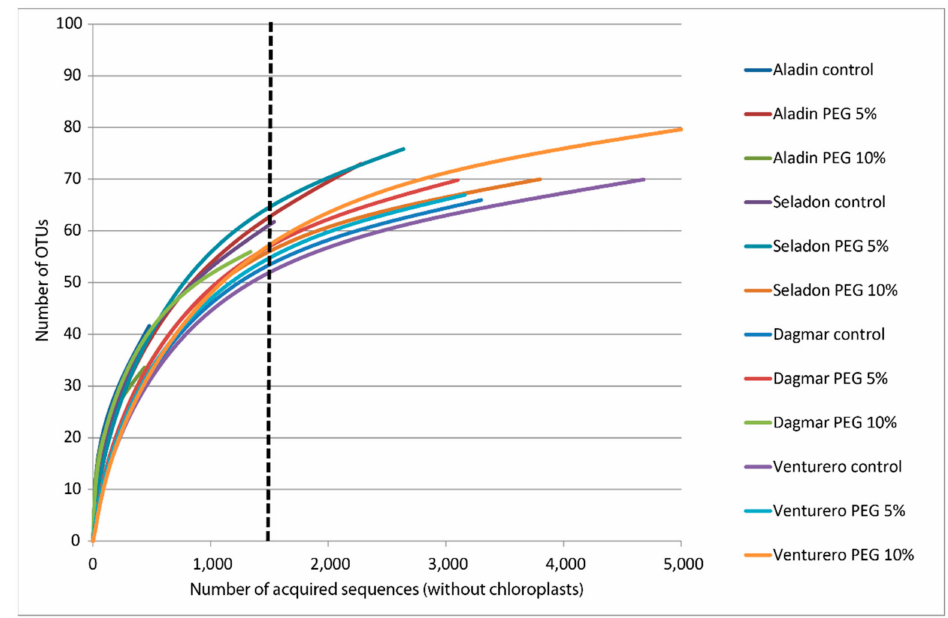
Figure 1. Rarefaction curves of microbial clusters in the microbiomes of di ff erent wheat varieties cultured in vitro. Rarefaction curves were assembled showing the number of operational taxonomic units defined at a 97% sequence similarity, relative to the number of total sequences. The dashed vertical line indicates the number of sequences subsampled from each sample to calculate the alpha diversity